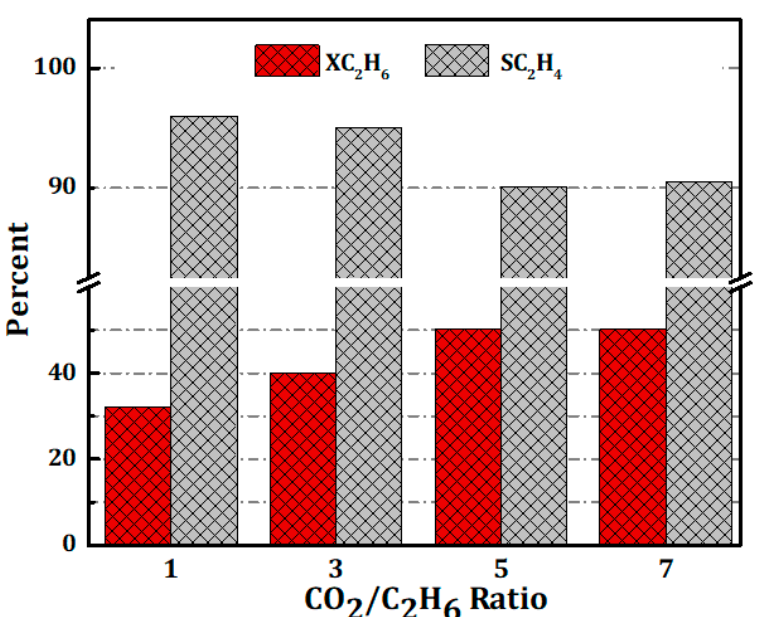
Figure 10. Effects of partial pressure of CO 2 on the conversion of ethane and selectivity of ethylene for the Cr(8)/MOS catalyst at different temperatures.